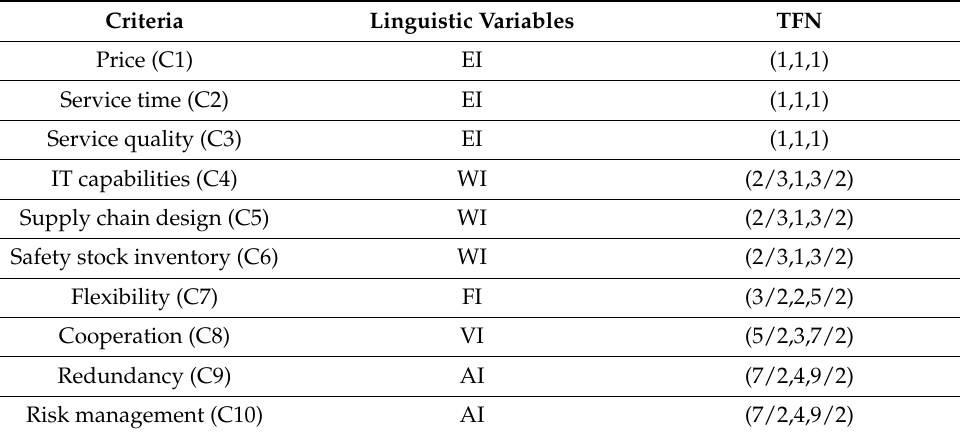
Table 7. Linguistic evaluations of